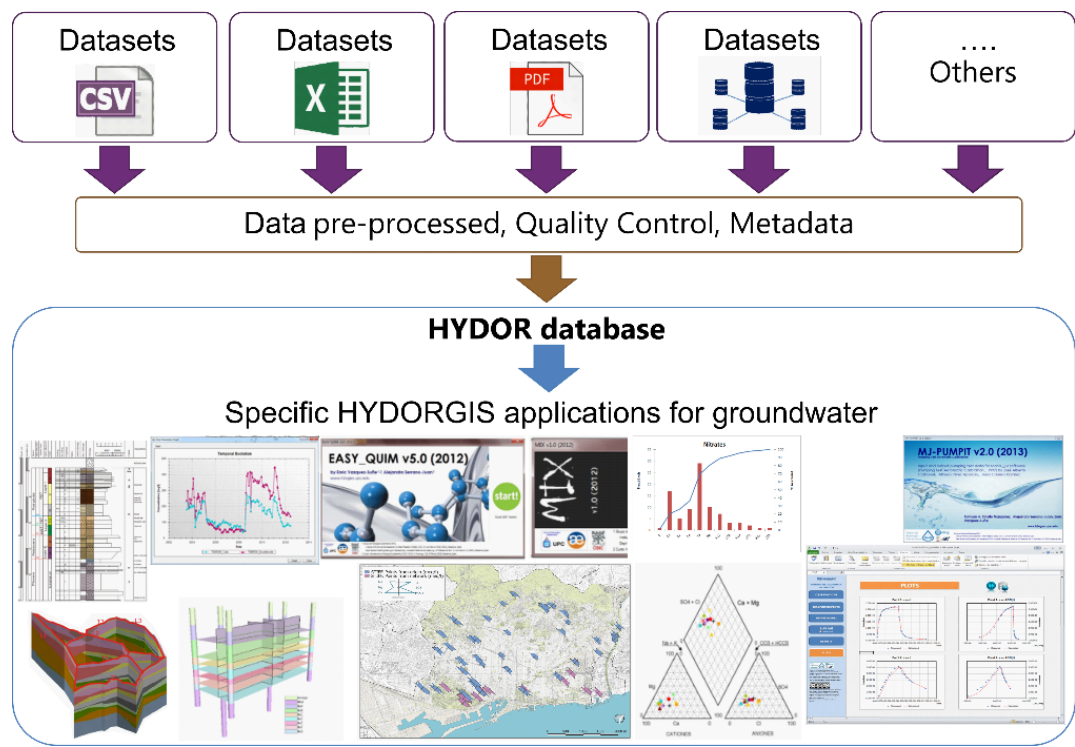
Figure 1. Workflow scheme of migration and integration of multiple sources into HYDORGIS tools.